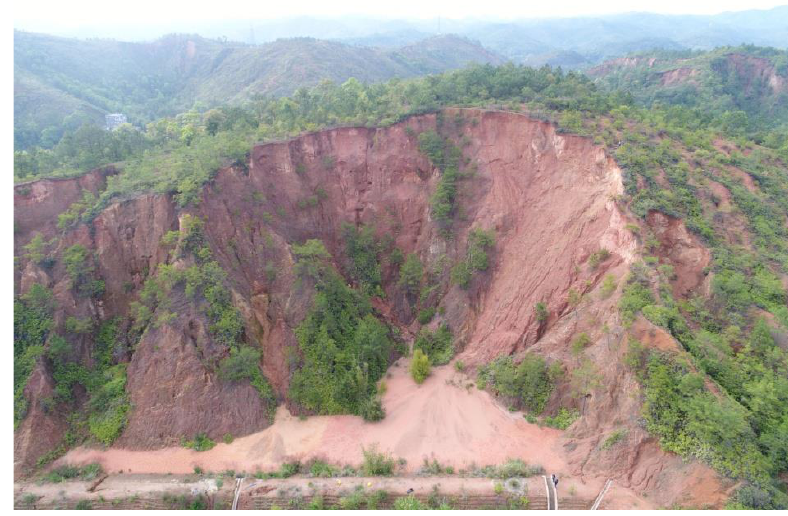
Figure 1. A typical collapsing gully in the hilly granitic regions of southern China.